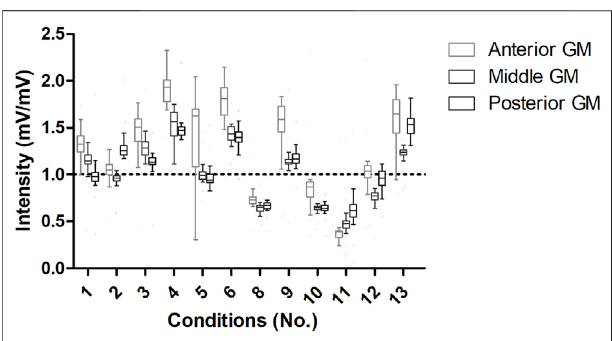
FIGURE 3 | EMG intensity of crutch patterns locomotion. The horizontal line indicates the median reference of the control condition. When EMG intensities are above and below the horizontal line, there was more and less activation for the portions of the GM than under the control condition, respectively. GM, gluteus